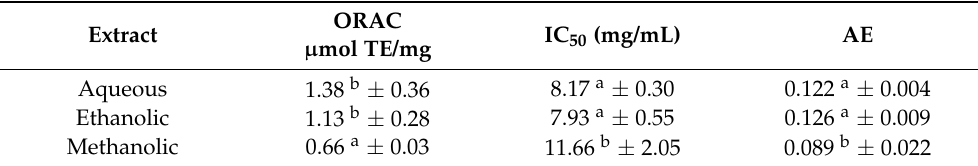
Table 1. ORAC and DPPH values for S. nigra extracts. Values are mean ± SD, n = 3. Different letters indicate statistically significant differences ( p < 0.05) among groups. Extract